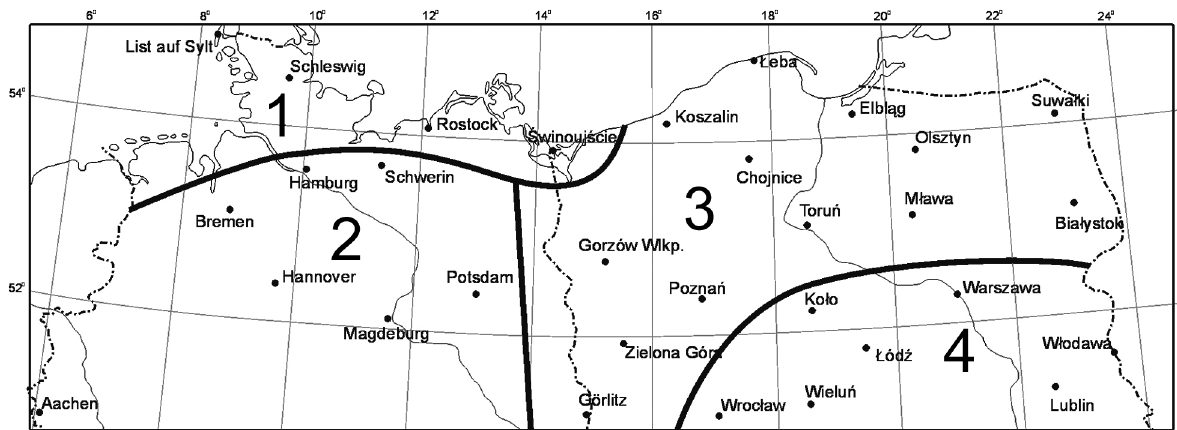
Fig. 4. The results of the regionalisation together with the distribution of meteorological